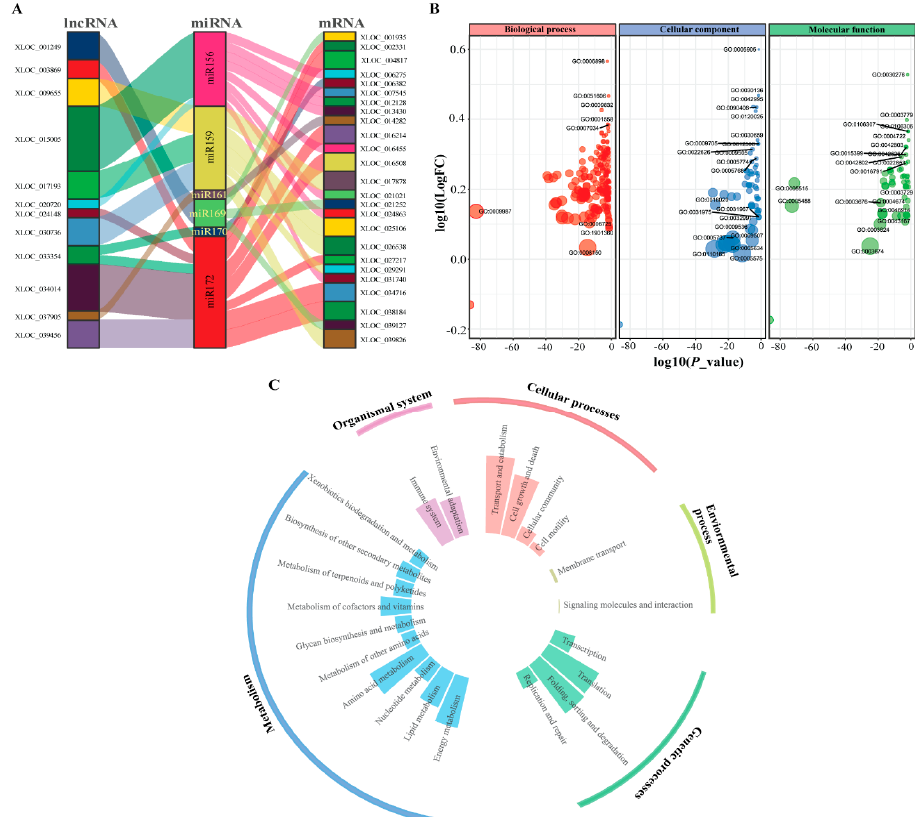
Figure 5. Interaction network and functional enrichment analyses of differentially expressed lncRNAs in white lupin. ( A ) Interaction network among lncRNA, miRNA, and mRNA. ( B ) Gene ontology (GO) enrichment of DE-lncRNAs targets analysis. ( C ) Kyoto Encyclopedia of Genes and Genomes (KEGG) enrichment of DE-lncRNA targets.